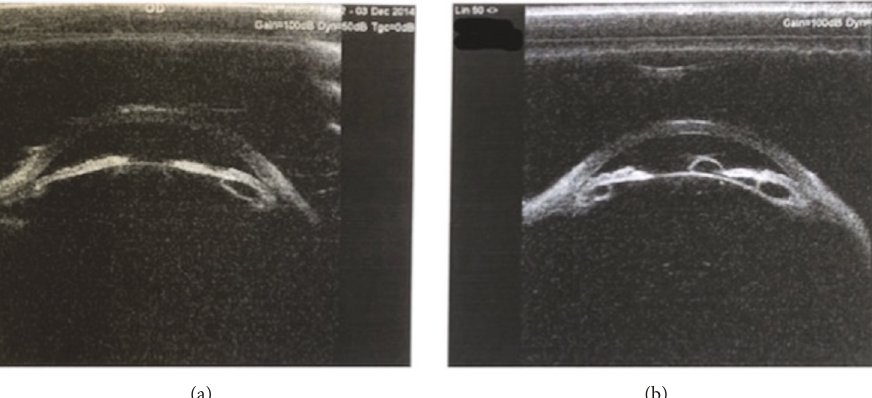
Figure 2: Ultrasound biomicroscopy (UBM) images of (a) right and (b) left eyes showing multiple iris pigment epithelial and ciliary body cysts in both eyes prior to stopping topical